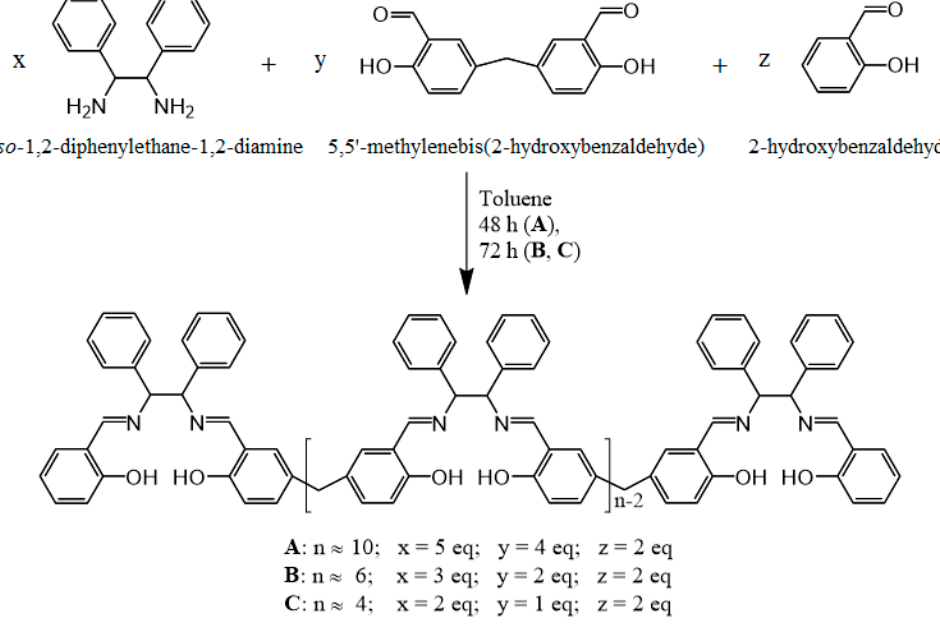
Scheme 1. Schematic reaction pathways of the Oligo–Salen ligands.